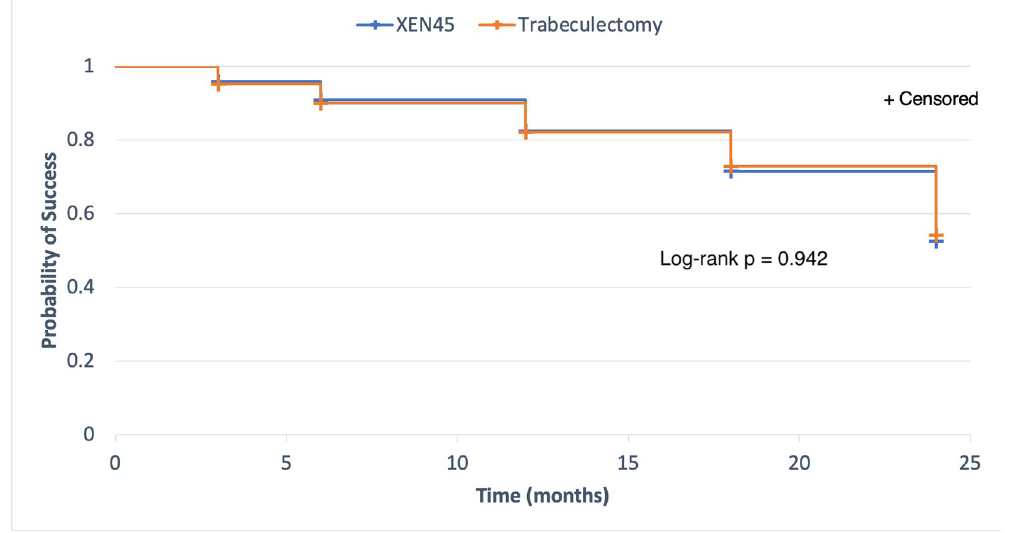
Fig 6. Kaplan-Meier curve showing the probability of achieving any success criteria in the XEN implant and trabeculectomy groups.